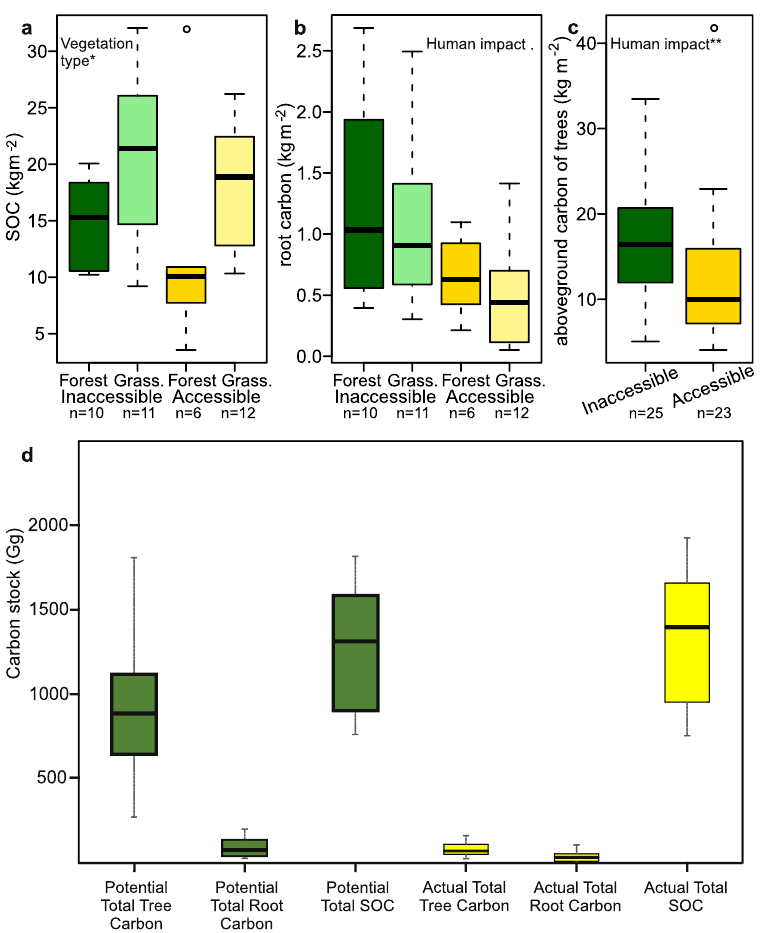
Figure 5. Comparisons of carbon properties between inaccessible and accessible forest and grassland ( a – c ) and comparison of potential and actual landscape carbon stocks ( d ). ( a – c ) Comparisons of carbon contents in Soil Organic Carbon (SOC) ( a ), root biomass ( b ) and aboveground biomass of trees ( c ). Significant relationships between the structural properties and fixed effects, found upon analysis using GLMM’s, are noted within the figures ( ** p < 0.01, * p < 0.05, p < 0.1; Table S18). ( d ) Estimated values of the potential (green) and current (yellow) carbon stocks for aboveground tree carbon, root carbon and soil organic carbon (SOC) at the landscape scale for the high elevation area mapped of the Cordillera Urubamba. Values estimated using carbon stock values from inaccessible and accessible forest and grassland (Table S8) extrapolated over the areas calculated using landscape mapping (132,660 km 2 ; Tables S1 and S9). Actual values of the carbon stocks can be found in Table